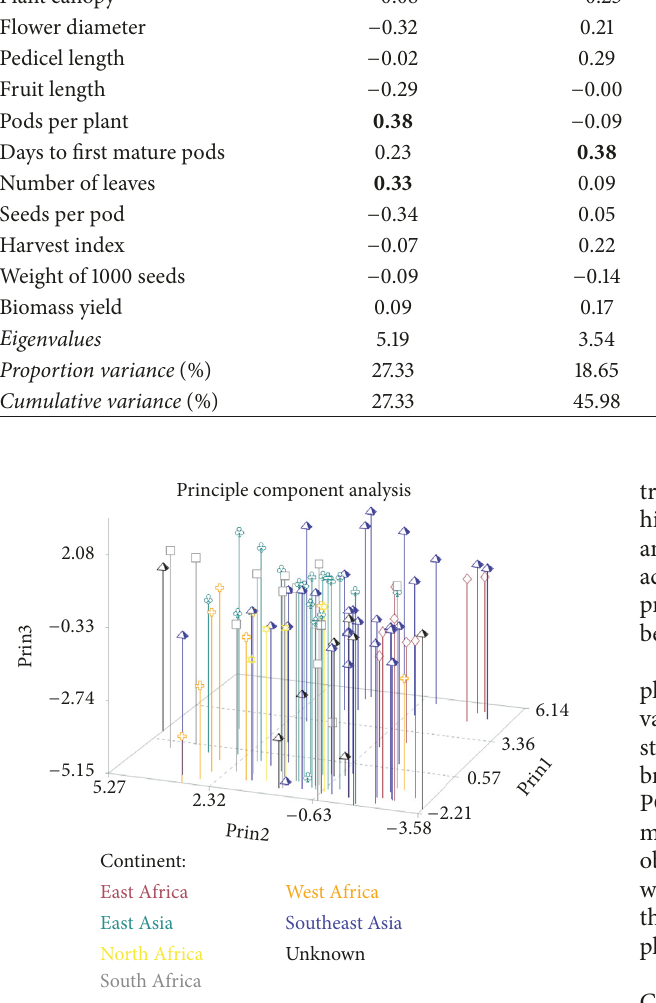
Figure 2: Three principle components showing relationship among quantitative traits of studied